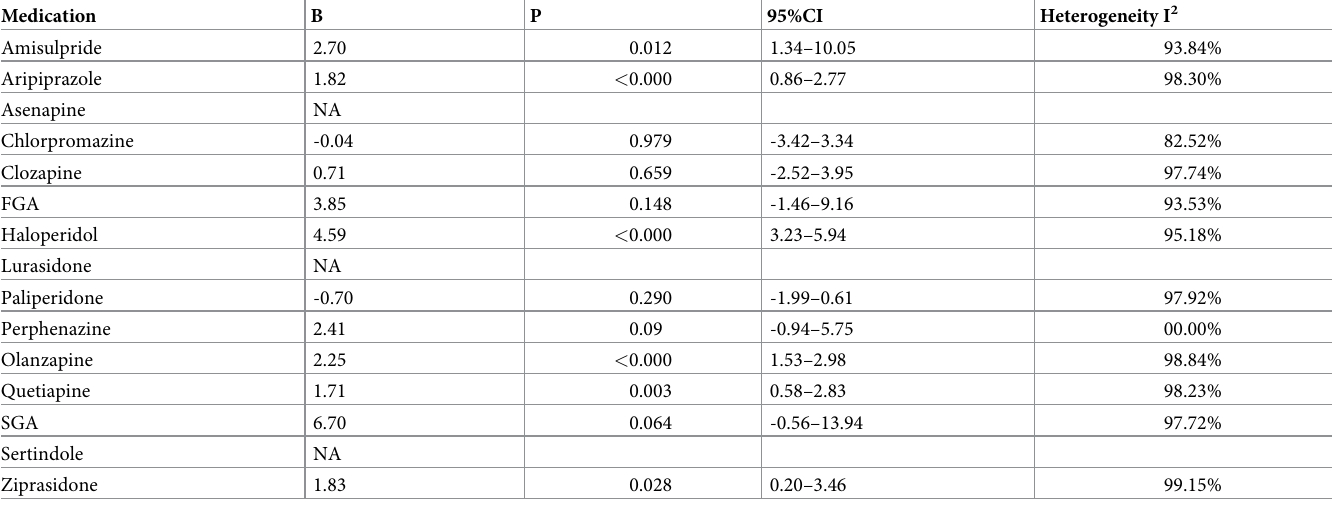
Table 3. Meta regression analysis comparing body weight changes between AP-switch and